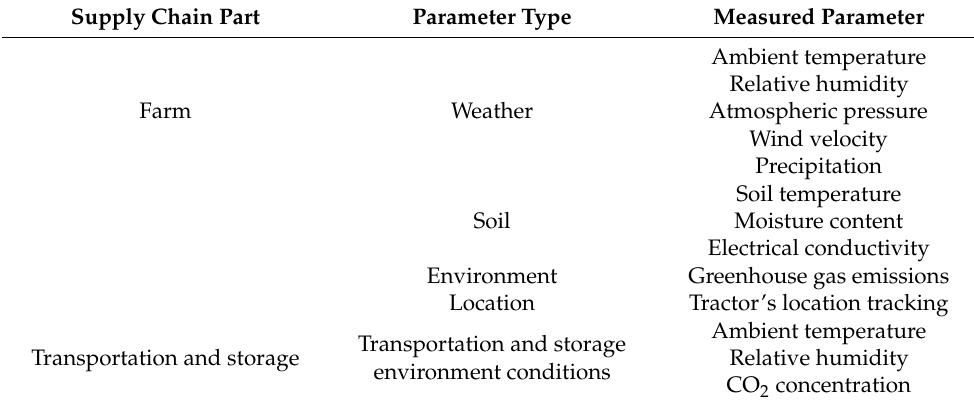
Table 2. The main parameters measured by IoT systems across the agri-food supply